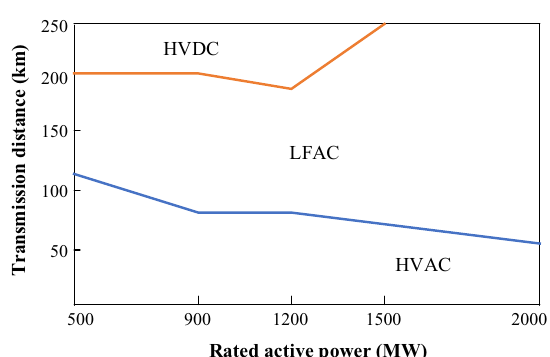
Fig. 20 Relationship between active power and distance for the three